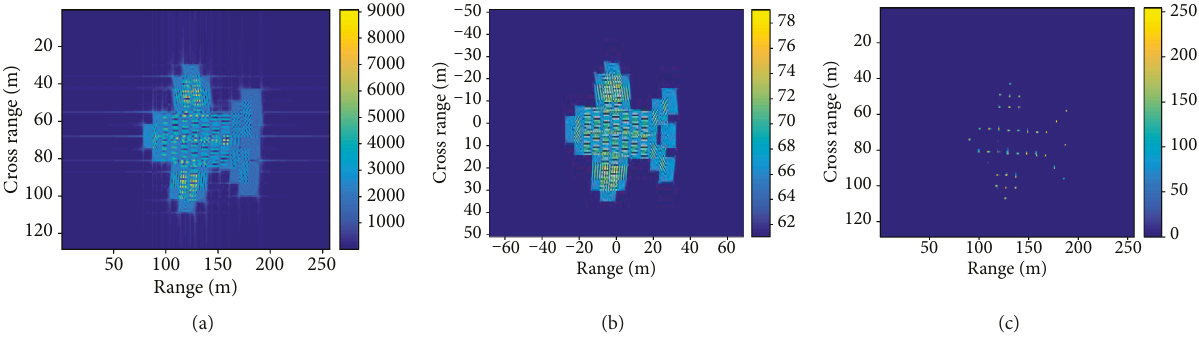
Figure 6: Imaging results with the target ’ s motion parameters P3. (a) RD algorithm. (b) Keystone transform. (c) The proposed